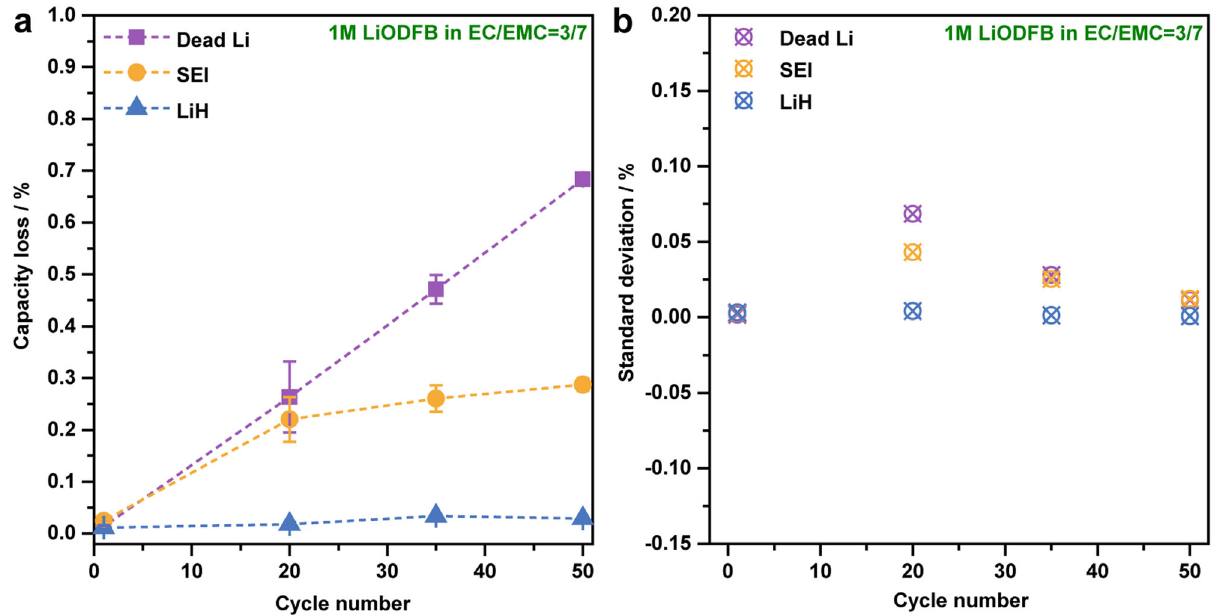
Fig. 4 The quantitative results of inactive Li of the 1 M LiODFB in EC/EMC electrolyte. a The capacity losses consumed by dead Li metal, SEI and LiH. Error bars indicate the standard deviations of the average values of MST quantitative results. b Standard deviation of the quantitative